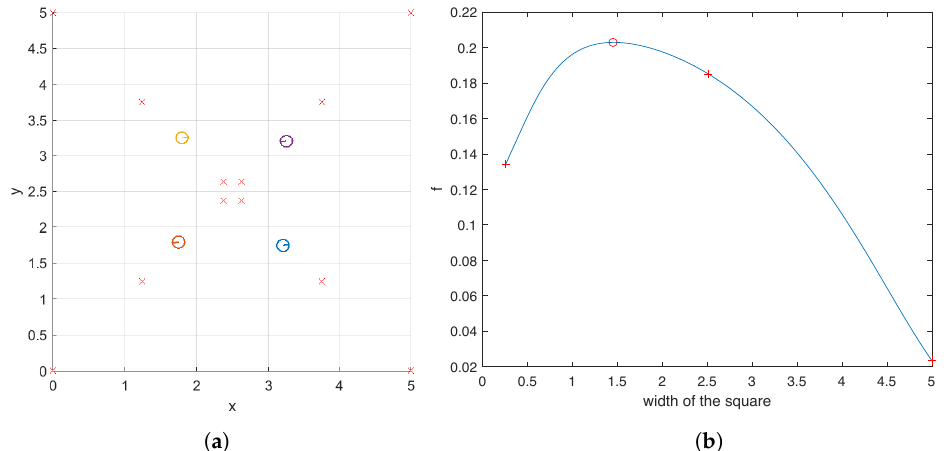
Figure 11. The base points of helices belonging to a few square carpets ( a ) and the value of f ( θ ) as the width of the square increases ( b ). The three crosses in ( b ) correspond to the three carpets marked by crosses in ( a ). The difference in the phase shifts of two helices located on adjacent vertices is π . The flow meter is (7) with W = 5. Table 8. The runtimes, iteration counts, and numbers of function evaluations entailed by the hybrid method for the cases of three and four helices. The flow meter is (7) with W = 5. (Forty-eight computer cores are